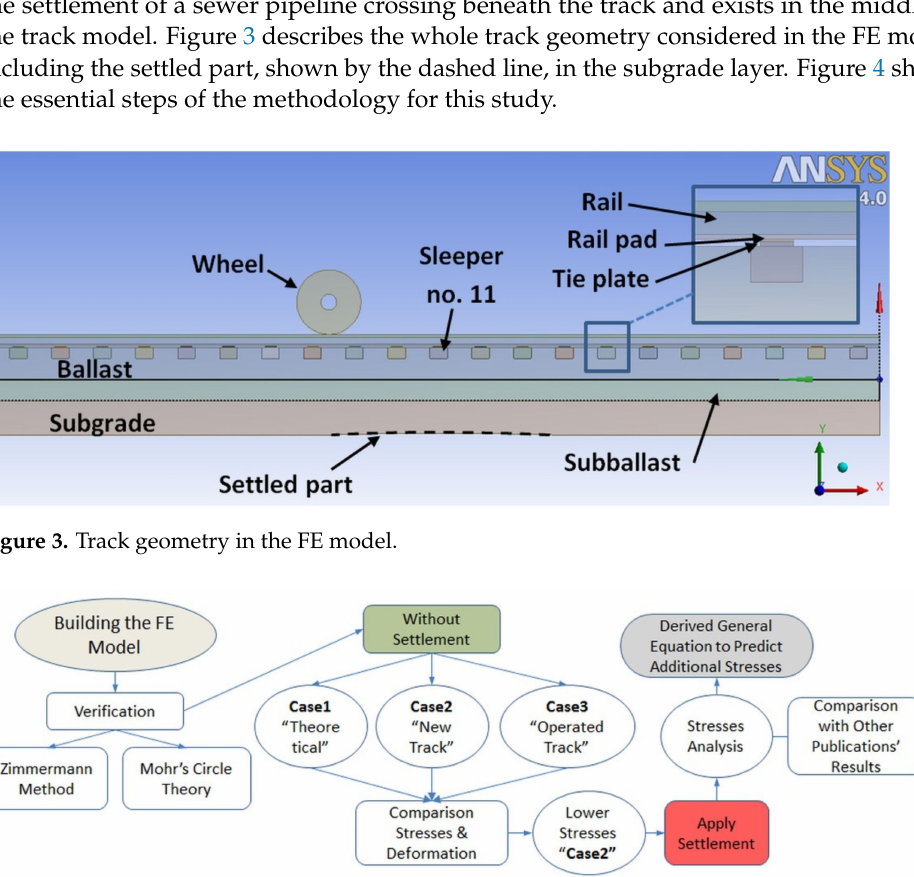
Figure 4. Structure of the research